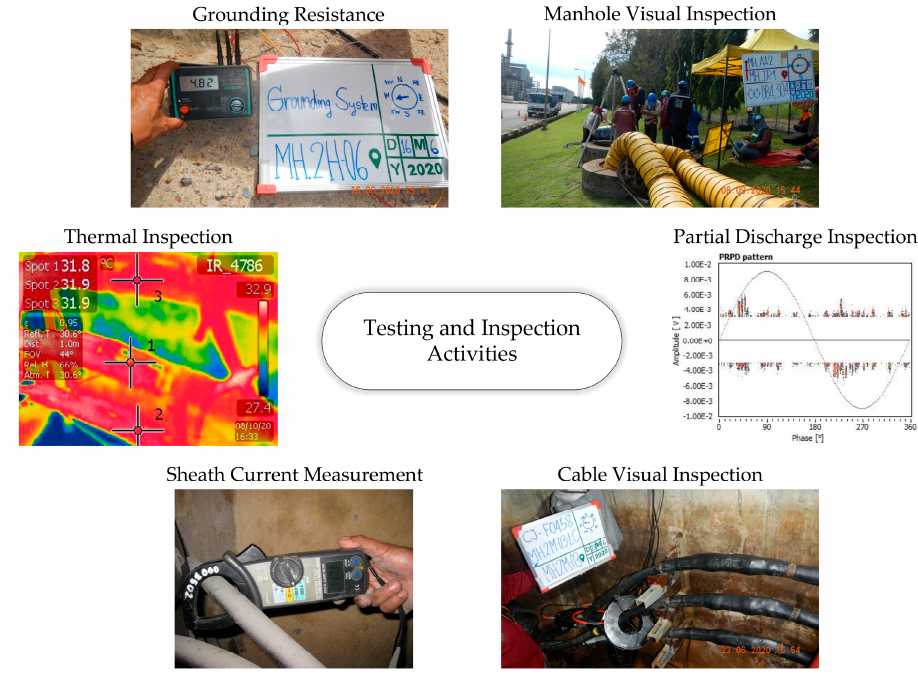
Figure 3. Visual inspection, testing, and measurement of underground cable system. Table 1. Testing and inspection methods with scoring and weighting for health index calculation.